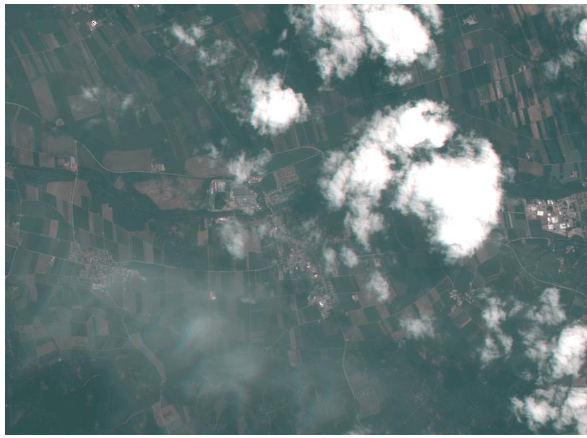
Figure 4. Example stereo image with different cloud